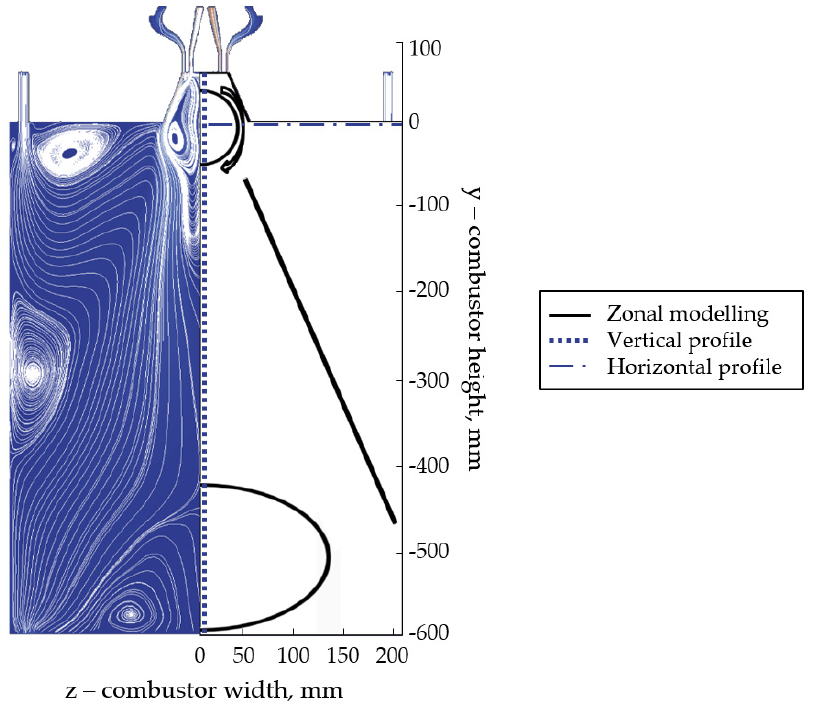
Figure 8. Sketch of the OFC and selected profiles.